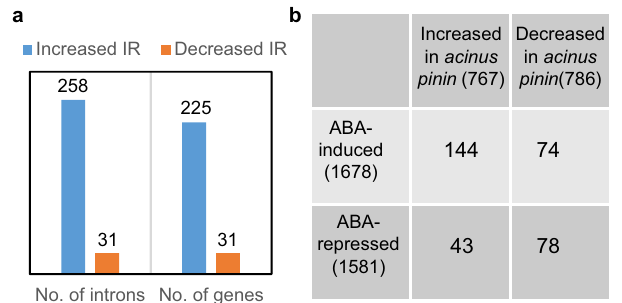
Fig. 3 RNA-sequencing analysis of acinus-2 pinin-1 showed differential intron retention and expression level of many genes. a Number of introns that showed increased or decreased intron retention in acinus-2 pinin-1 and the number of genes that contain these introns. b Comparison between genes differentially expressed in acinus-2 pinin-1 and ABA-responsive genes. RNA-seq was conducted using 14-day-old light-grown seedlings for both pinin-1 background (Fig. 2d and Supplementary Fig. 4b). These results indicate that the acinus-2 pinin-1 double mutant is hypersensitive to ABA, and that AtACINUS and AtPININ are redundant negative regulators of ABA responses.